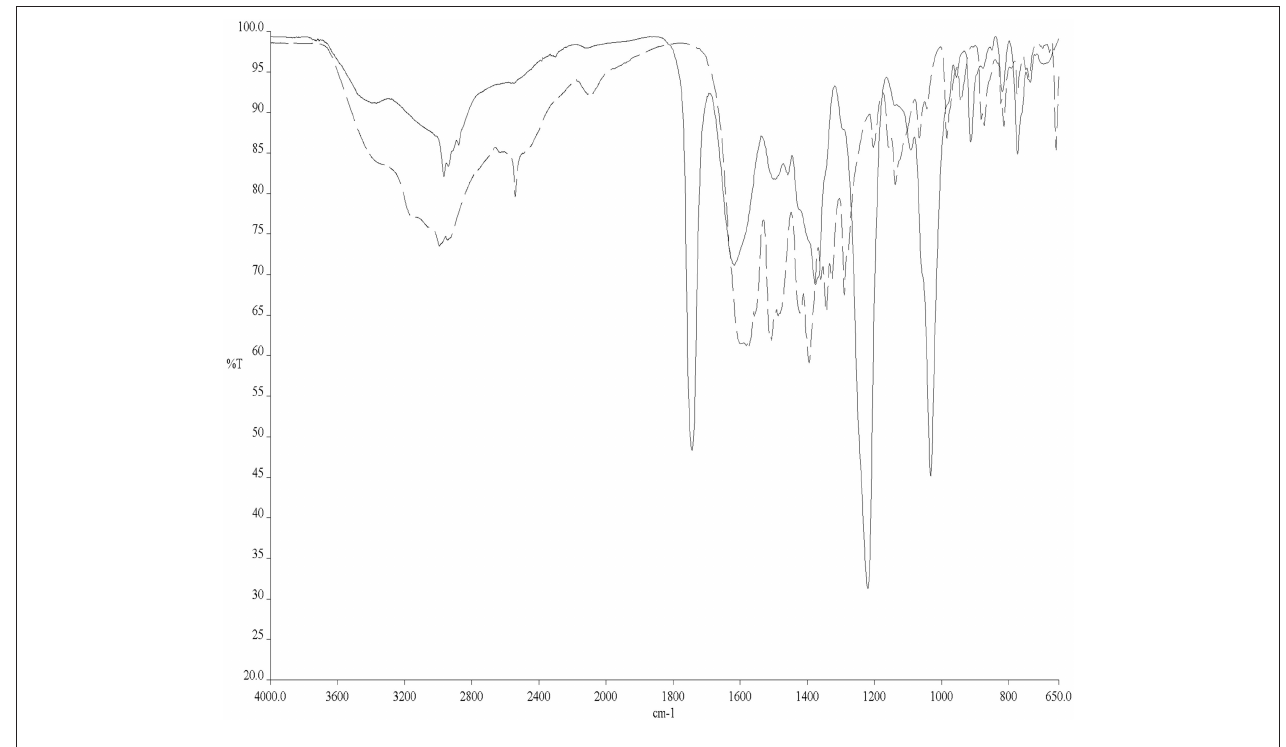
FIGURE 2 | ATR-FTIR spectra of Cys (dashed line) and Cys/AF adducts (solid line).